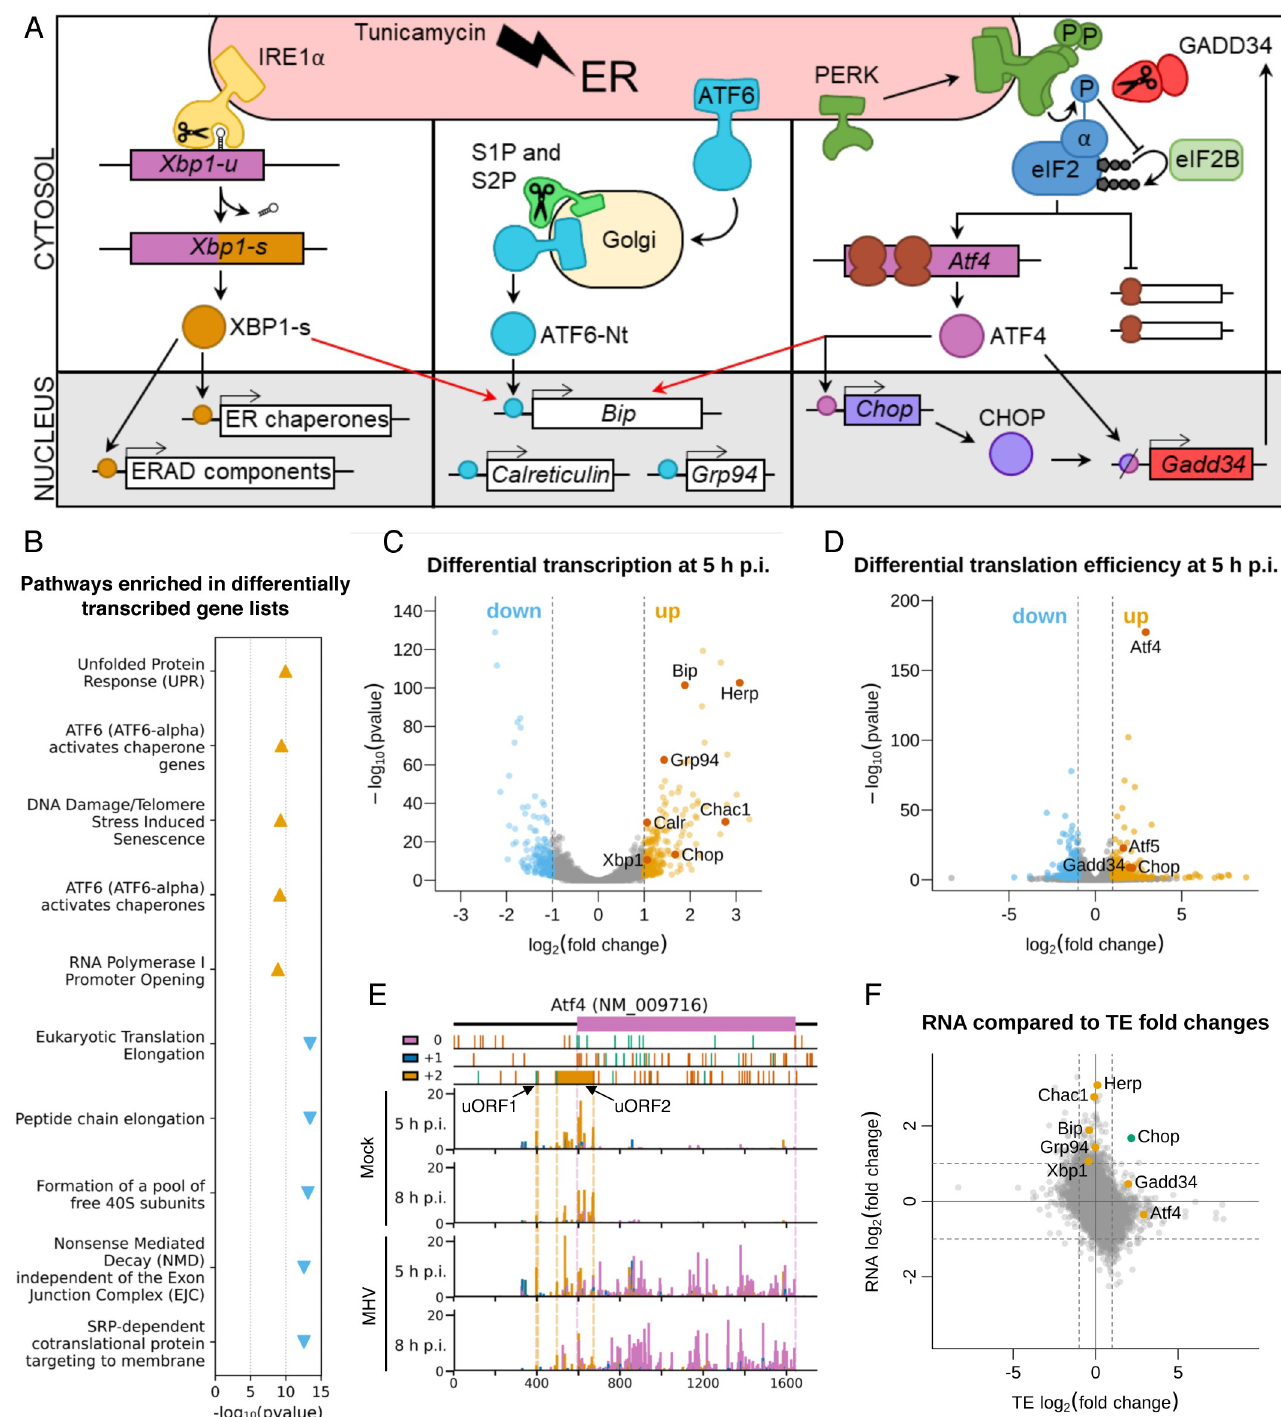
Fig 1. Ribosome profiling reveals the unfolded protein response as a key pathway in the host response to MHV-A59 infection. (A) Schematic of the three branches of the UPR (IRE1 α , ATF6, and PERK). ERAD = ER-associated protein degradation. (B) Top five most significantly enriched Reactome pathways [11] associated with the lists of transcriptionally up-regulated genes (orange triangles pointing upwards) and transcriptionally down-regulated genes (blue triangles pointing downwards), plotted according to the false discovery rate (FDR)-corrected p value of the enrichment. Full results, including pathway IDs, are in S3 Table. (C) Volcano plot showing the relative change in abundance of cellular transcripts and the FDR-corrected p value for differential expression between the mock and infected samples (n = 2 biological replicates). Grey vertical lines indicate a transcript abundance fold change of 2. Genes which have fold